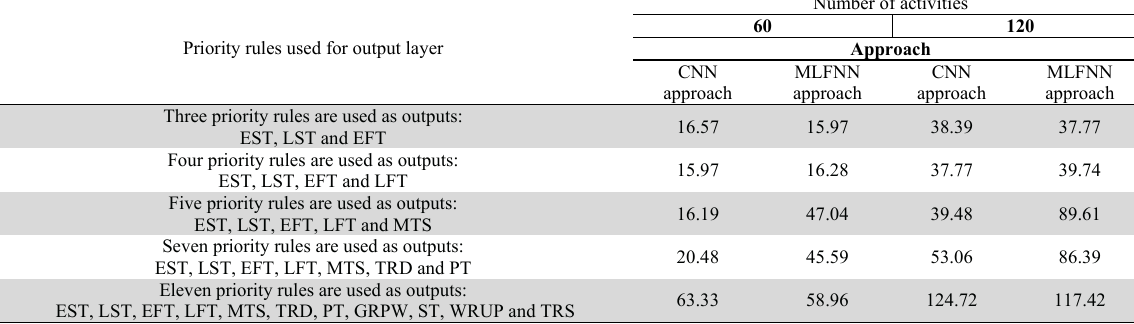
Percentage of average deviations from critical path lower bound for the J60 and J120. The average deviations obtained by our algorithm using the CNN approach, represent that the CNN approach performs better compared to the MLFNN approach developed in another article.